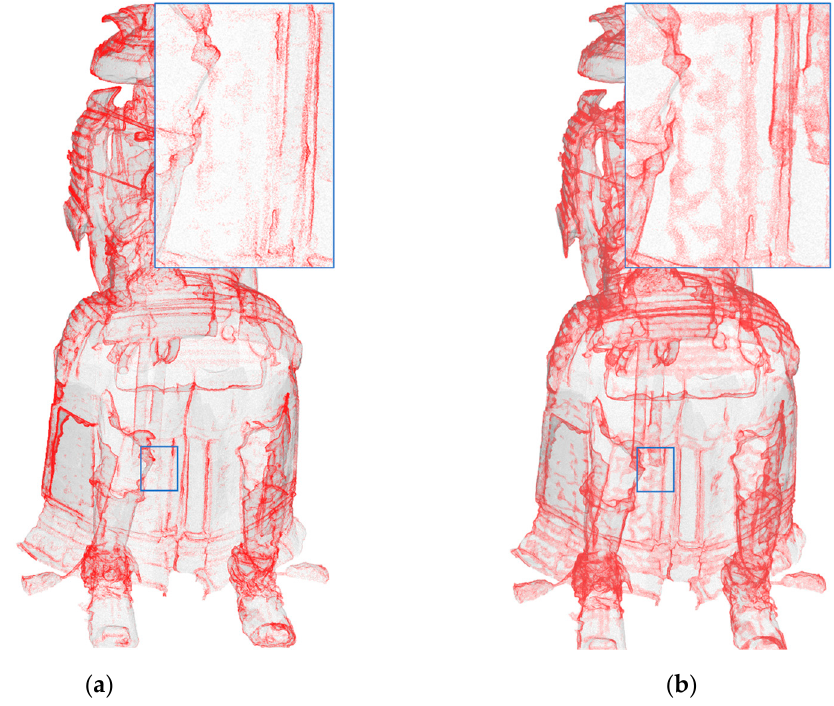
Figure 21. Edge highlighting by fusing extracted edge points with the 3D-scanned points in Figure 20a. Figure ( a ) shows the result of fusing the initially extracted edge points in Figure 20b, and Figure ( b ) shows the results of fusing the upsampled edge points in Figure 20c.